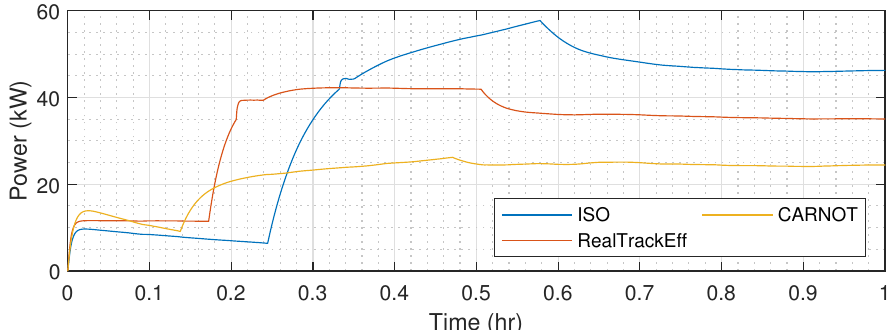
Figure 16. LFC power of the 3